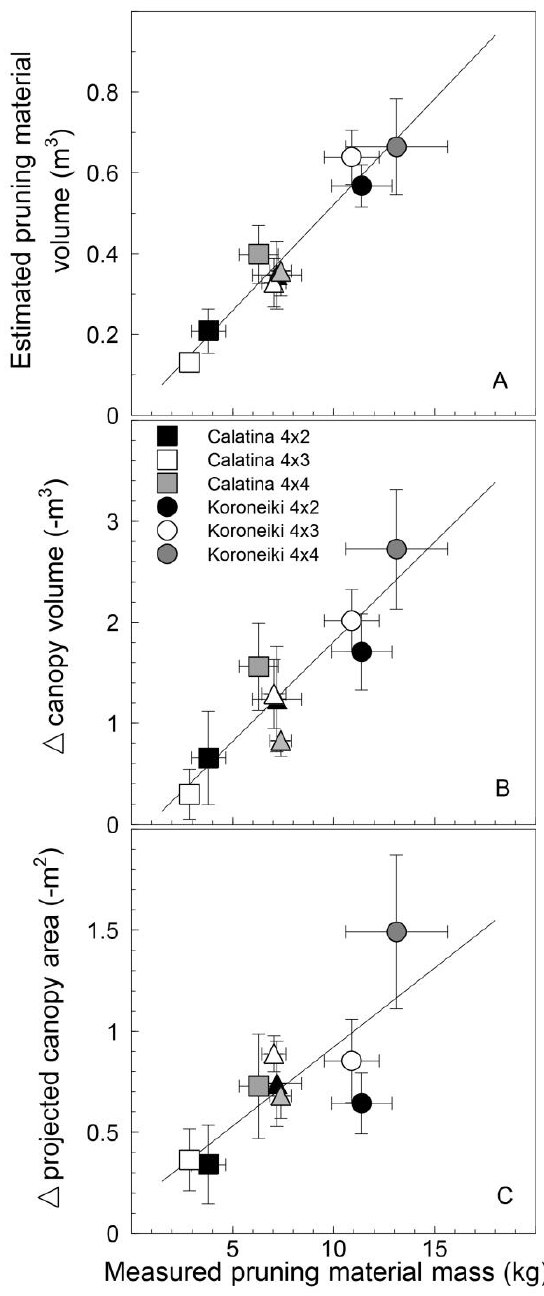
Figure 6. Relationship between measured pruning material mass and: the estimated pruning material volume ( A ), the reduction ( ∆ ) in canopy volume ( B ) and in projected canopy area ( C ) after pruning (canopy volume/projected area before pruning-canopy volume/projected area after pruning) measured in olive trees cvs. Koroneiki, Biancolilla and Calatina. Symbols are means of 5 trees ± standard error for each cultivar-planting distance combination. Equations: y = 0.05 x – 0.003, R 2 = 0.95 ( A ); y = 0.2 x – 0.17, R 2 = 0.84 ( B ); y = 0.08 x + 0.14, R 2 = 0.63 ( C ).